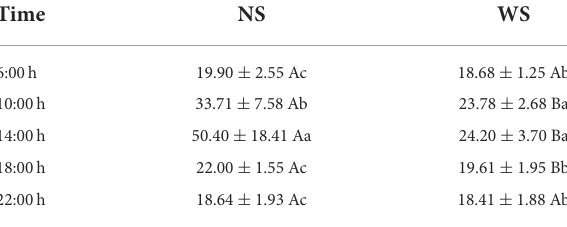
and in the shade (WS group), at different times of the day, in the rainy season, on Ilha do Marajó, Pará.